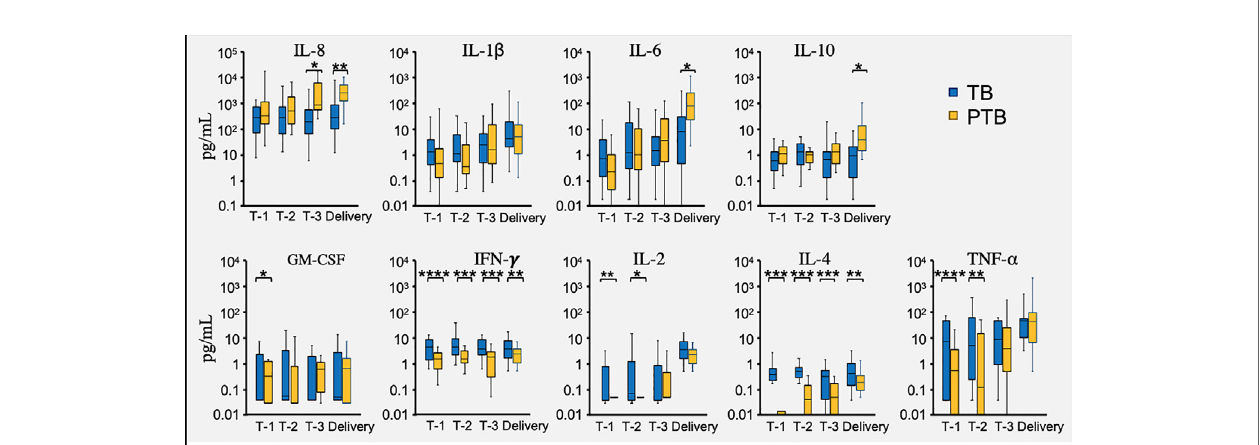
FIGURE 7 | Vaginal cytokine levels during PTB and TB pregnancies. Cytokines were measured in fl uid used to elute vaginal swabs from full term birth (TB) and preterm birth (PTB) women in the three trimesters of pregnancy (T-1, T-2, T-3) and at delivery. Blue bars represent the cytokine levels measured in the TB group, while the orange bars represent the cytokine levels in the PTB group. P -values were calculated using the unpaired t- test with Welch ’ s correction. The Y axis represent the cytokine levels in log scale. The asterisks indicate a signi fi cant difference in cytokine levels between the two groups (* P < 0.05, ** P < 0.01, *** P < 0.001 and **** P <